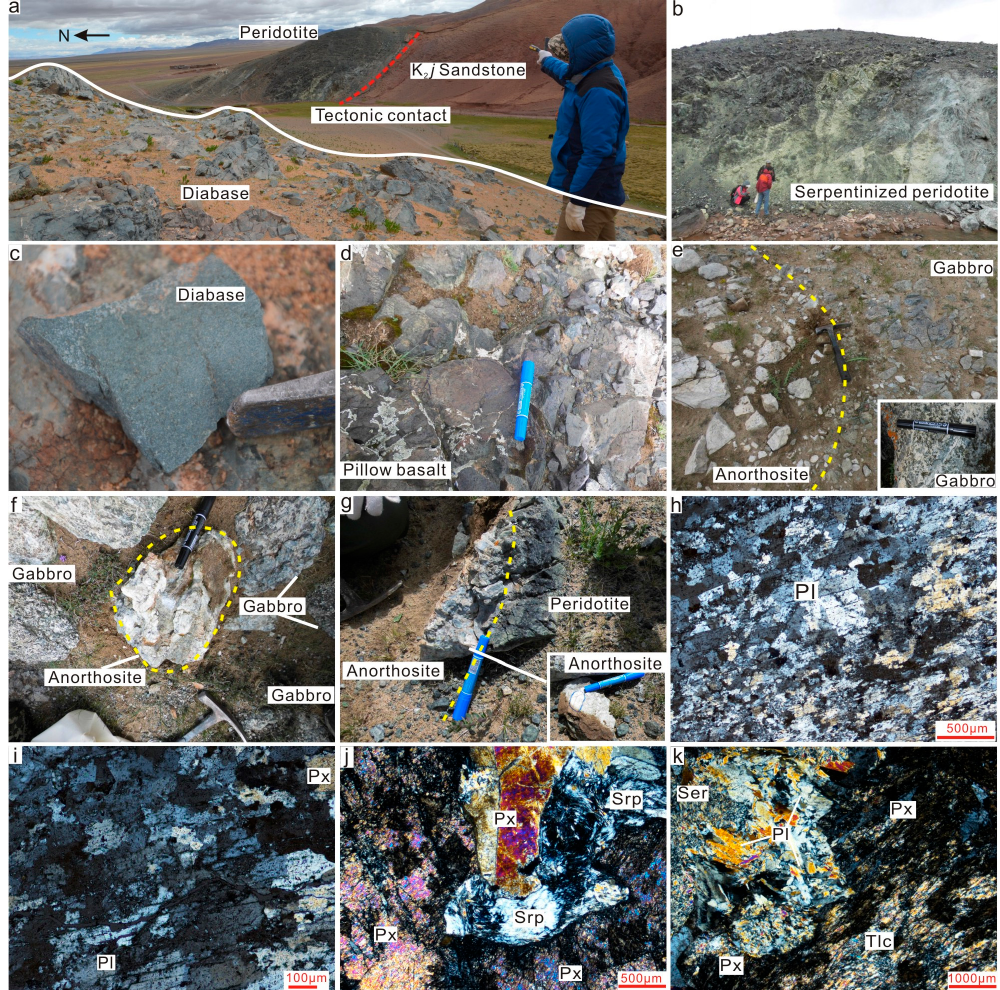
Figure 4. Field photos ( a – g ) and photomicrographs ( h – k ) of the Lanong ophiolites. ( a ) Dolerite and peridotite are in tectonic contact with the Late Cretaceous Jingzhushan Formation (K 2 j ); ( b ) serpentinized peridotite; ( c ) dolerite; ( d ) pillow basalt; ( e , f ) anorthosite and gabbro; ( g ) anorthosite and peridotite; ( h , i ) photomicrographs of anorthosite; ( j ,k) photomicrographs of gabbro. Note: ( a ) The red dashed line corresponds to tectonic contact between peridotite and sandstone; ( c ) geological hammer appears about 2 cm in this figure; ( d – g ) the marker pens are about 142 mm, and the yellow dashed line in ( e – g ) marks the contacts between anorthosite–gabbro ( e , f ) and anorthosite–peridotite ( g ). Abbreviations: Pl—plagioclase; Px—pyroxene; Srp—serpentine; Ser—sericite; Tlc—talcum. A fault tectonic contact separates mantle peridotite from the purplish-red sandstones of the